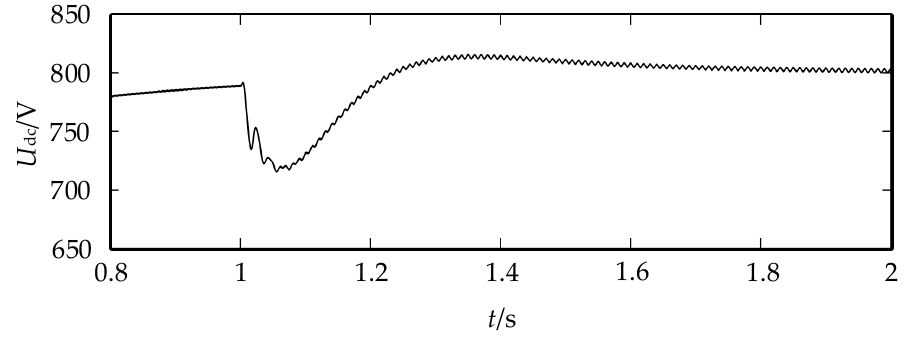
Figure 16. Three ‐ phase current with no DC voltage ripples.